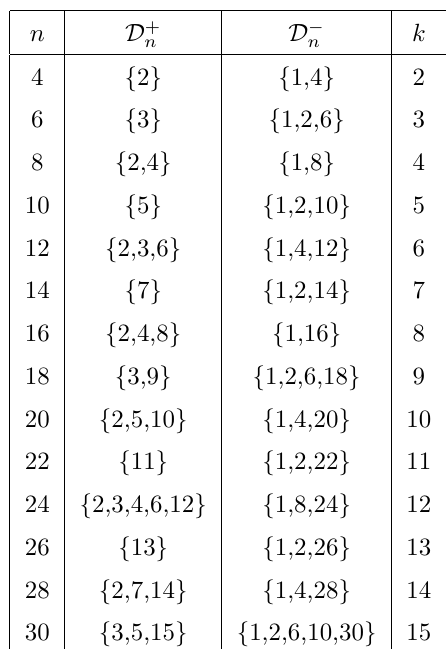
Table 2 . All solutions for N A = 1 and n (cid:20) 30 ((cid:12)rst column) are de(cid:12)ned by the set D + column), from which one gets (cid:8) + ( y ) from (3.16). The third column is for completeness, and it is n unique due to (3.19). The last column speci(cid:12)es the integer k of the solution